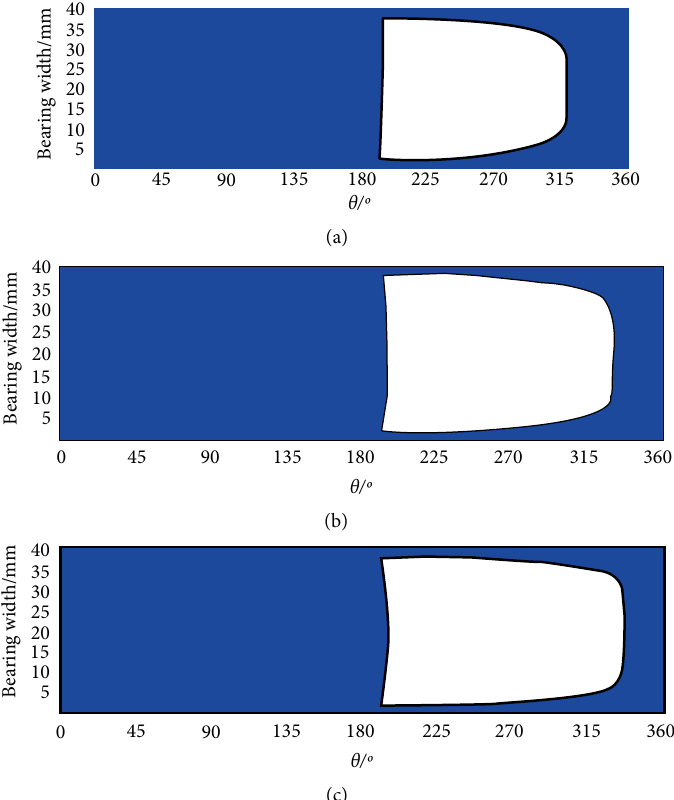
Figure 4: Influence of rotating speed n on cavitation distribution in R-E model. (a)